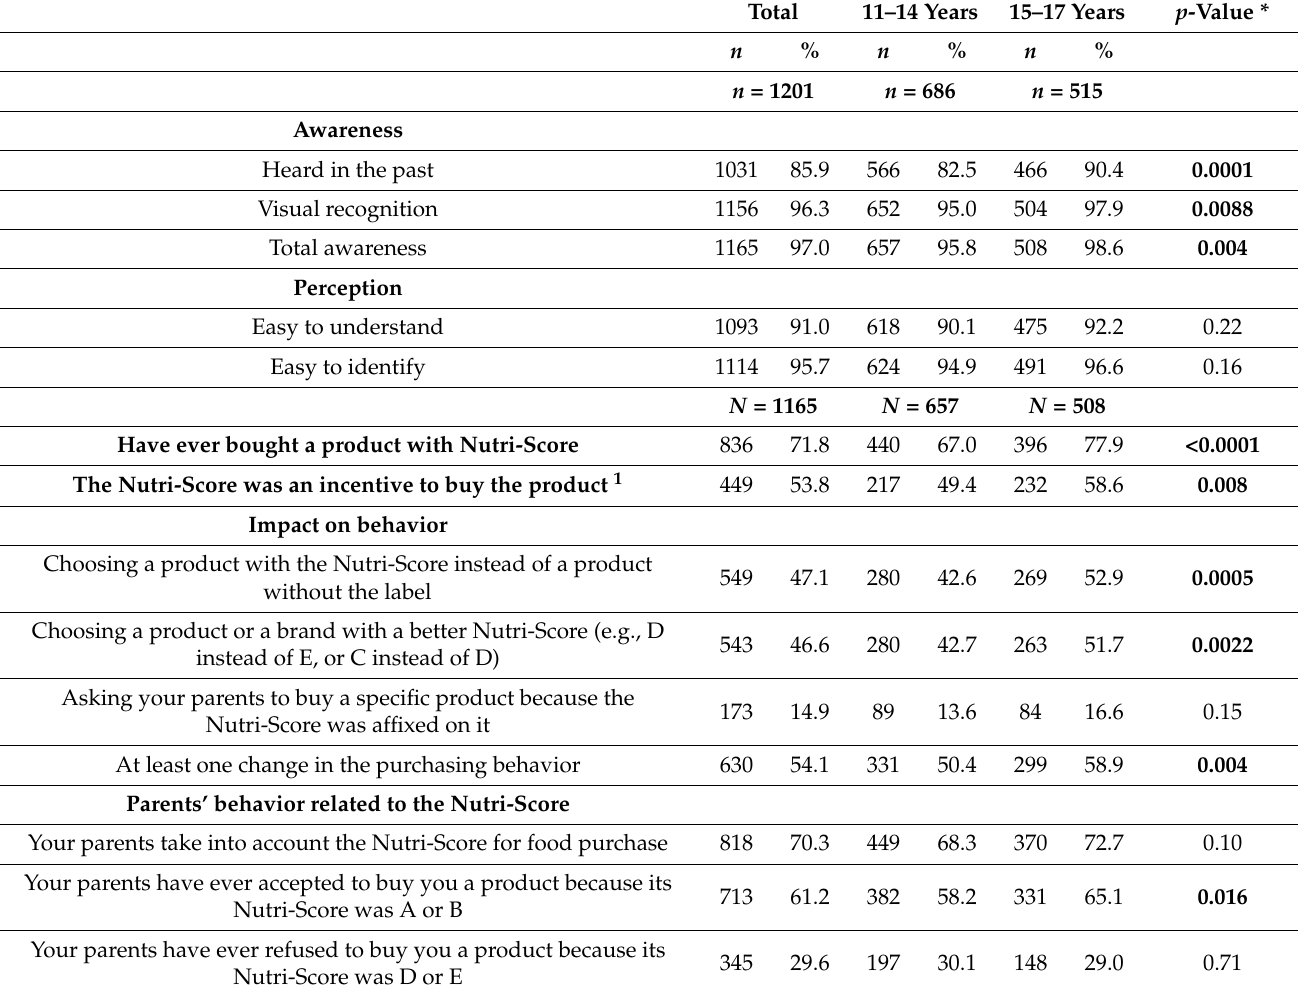
Table 3. Awareness, perception and purchasing practices related to the Nutri-Score label (weighted